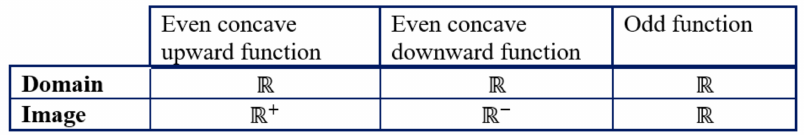
Figure 1. Definition of the domain and image of a power function given by Teacher